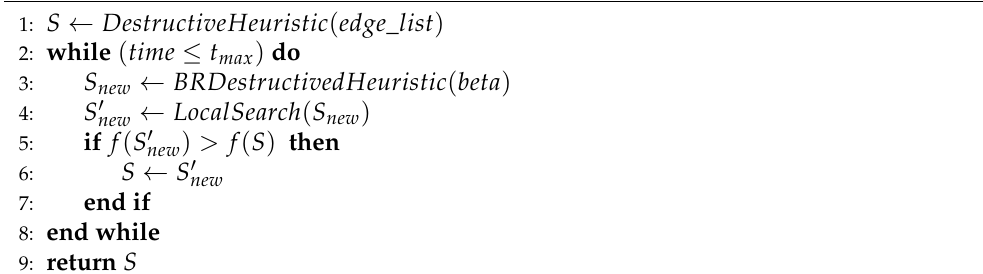
Algorithm 5 Multi-start biased-randomized destructive heuristic ( t max , beta , edge _ list